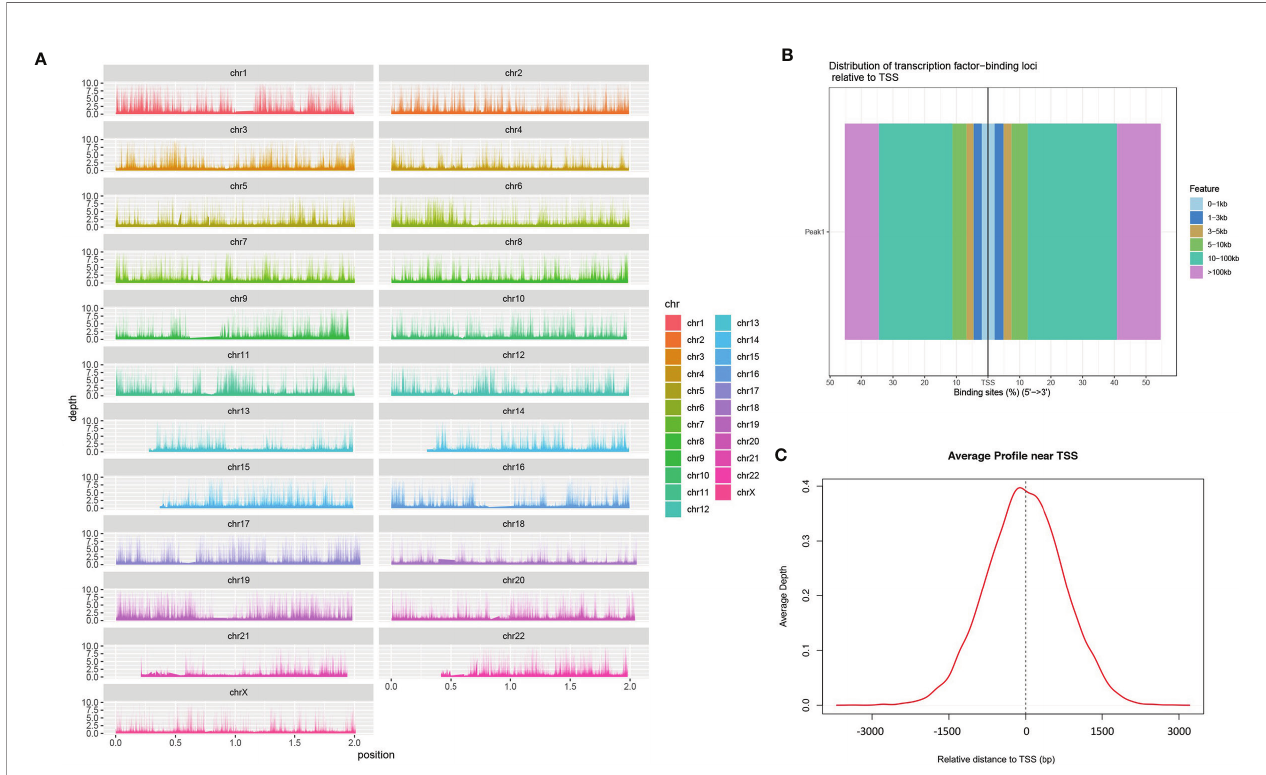
FIGURE 1 | Identi fi cation of chromatin open regions by ATAC-seq method. [ (A) genome coverage; (B) distribution map of transcription factors and TSS; (C) enrichment of Peaks in the TSS